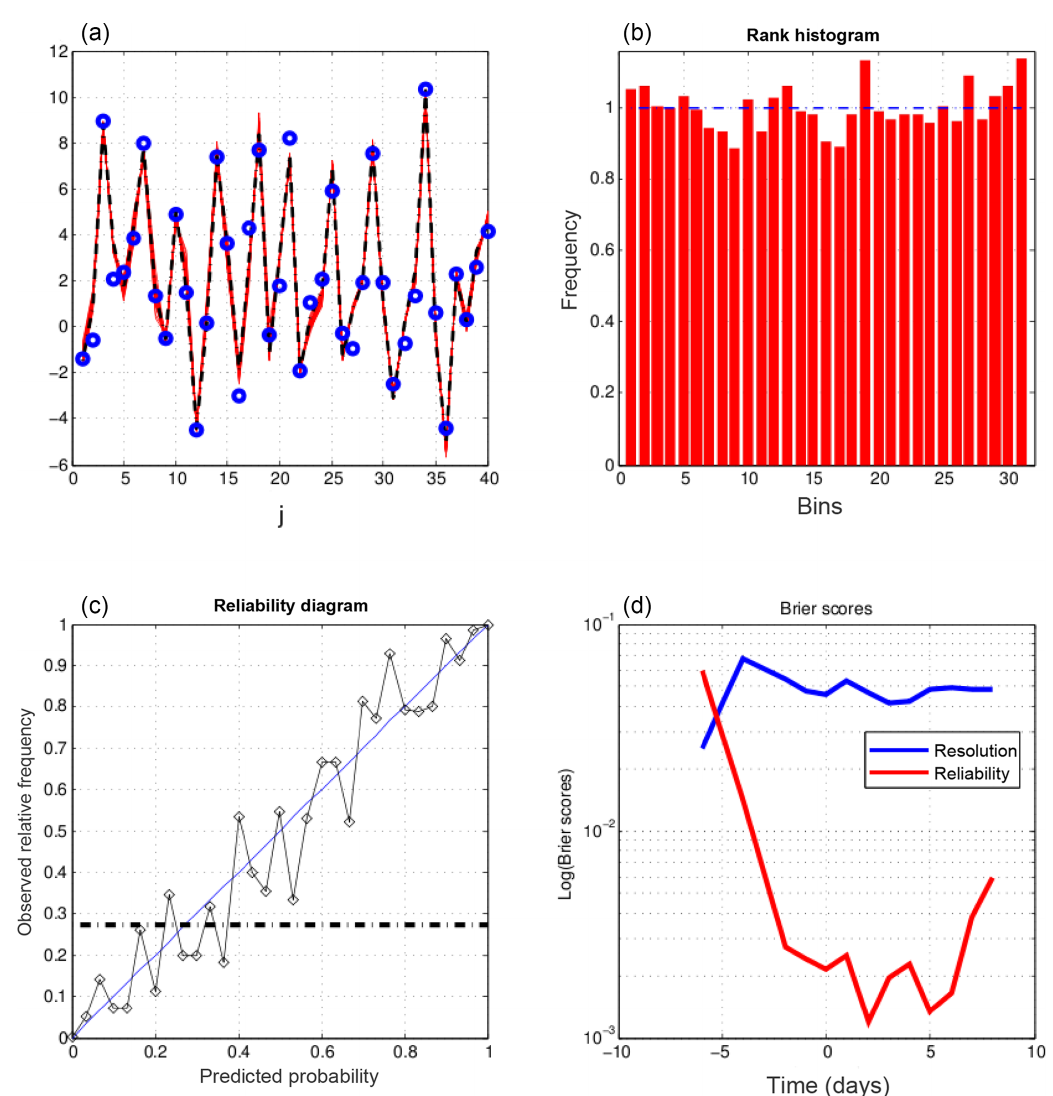
Figure 6. Further diagnostics of 10-day ensemble assimilations performed with QSVA EnsVAR. All diagnostics are performed at the end of the assimilation windows. (a) Truth (dashed black curve), observations (blue dots), and minimizing solutions (red curves), as functions of the spatial coordinate, at the end of one assimilation window. (b) Rank histogram for the variable x over all grid points and ensemble assimilations. (c) Reliability diagram for the event E = { x < 0 . 94 } , which occurs with frequency 0.29 (dashed–dotted horizontal curve), built over all grid points and ensemble assimilations. (d) Components of the Brier score (same format as in Fig.